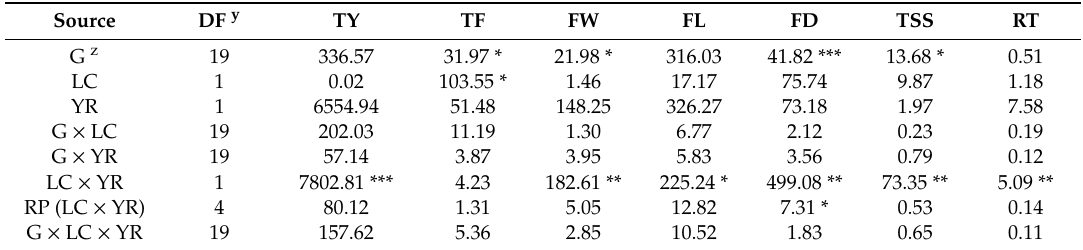
Table 1. Analysis of variance with mean square of twenty watermelon genotypes evaluated at Uvalde and Weslaco TX in 2018 and